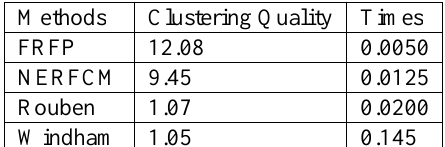
Table 6 Average Clustering Quality and times for data set